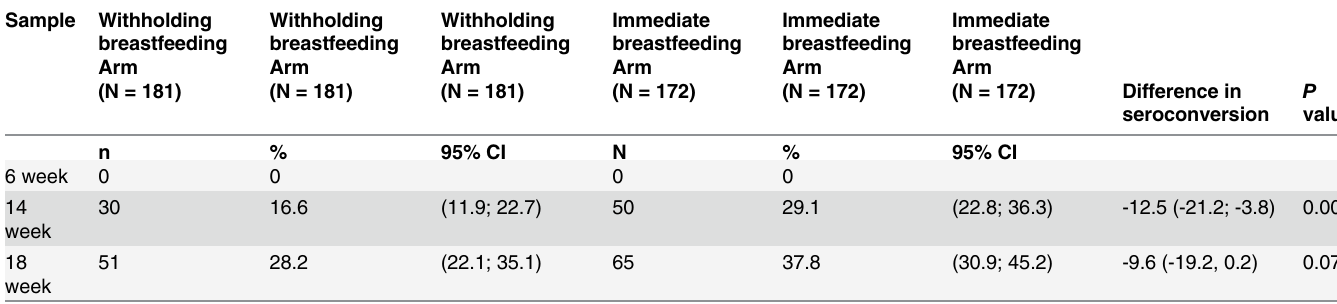
Table 3. Percent Anti-Rotavirus IgA Seroconversion.